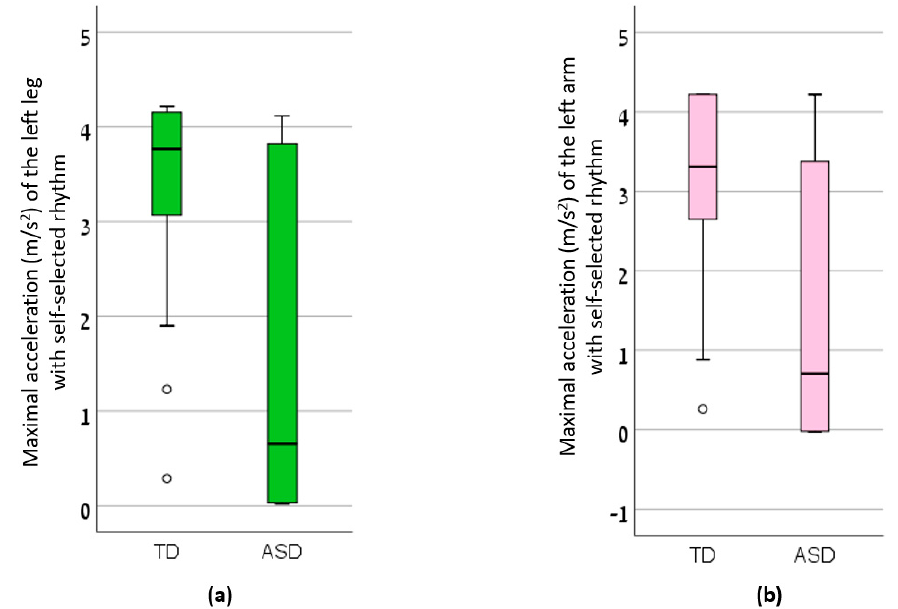
Figure 1. The maximal acceleration (m / s 2 ) of the ( a ) left leg with self-selected rhythm and ( b ) left arm with self-selected rhythm in Typically Developed (TD) children and children with Autism Spectrum Disorder (ASD).